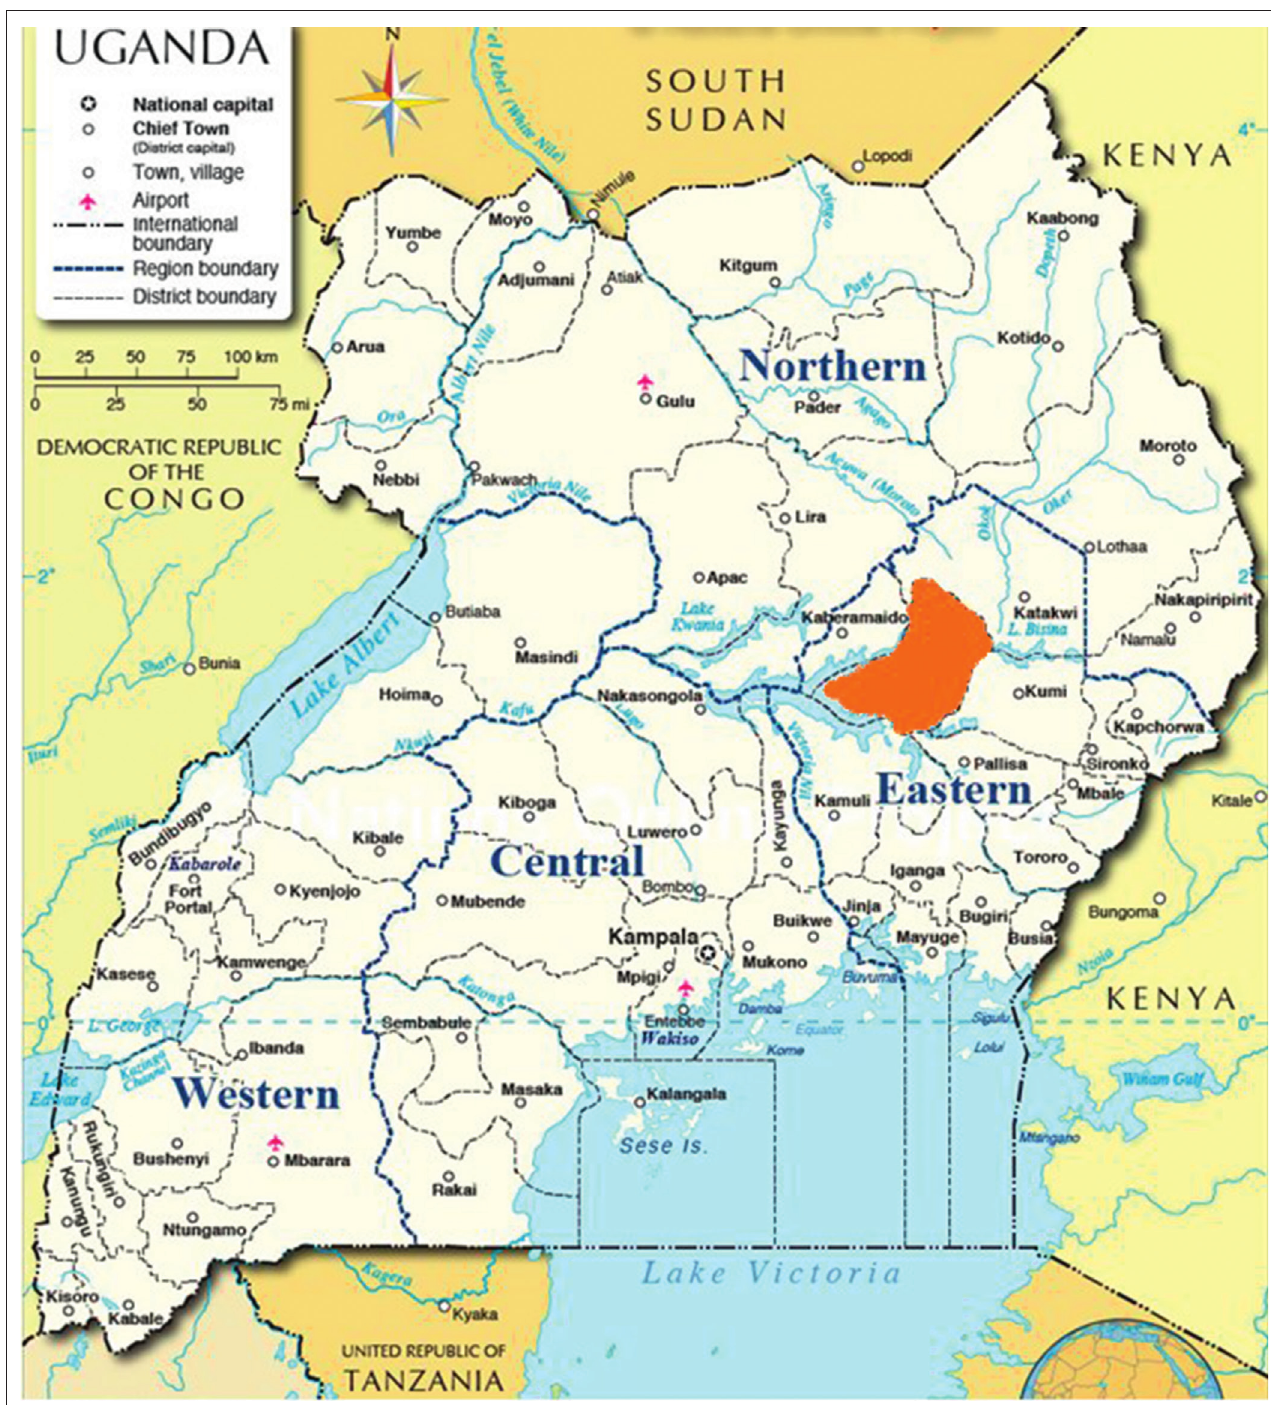
FIGURE 1: Map of Uganda showing location of Soroti District (shaded